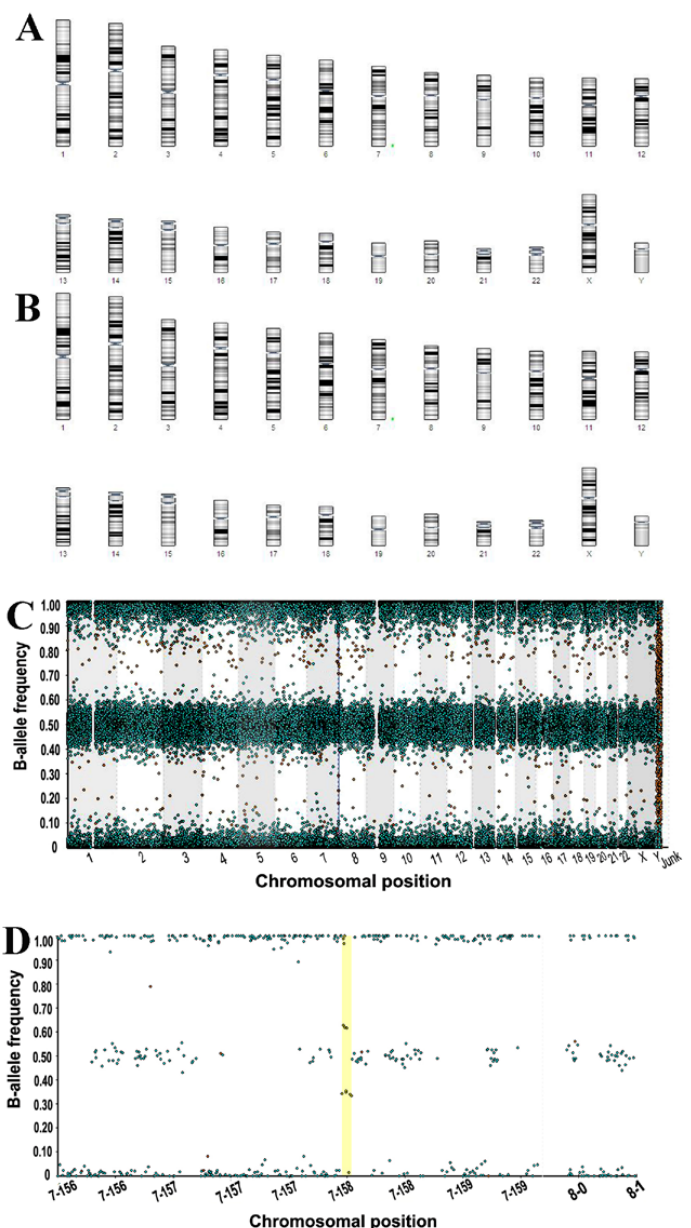
Figure 4. The results of molecular karyotyping of eMSC. ( A ) Karyotype of SHS-SP; ( B ) Karyotype of control cells; ( A , B ) scheme of genome profile with microduplication on chromosome 7; ( C ) entire genome profile with chromosome 7 microduplication; ( D ) chromosome 7 with microduplication; X on ( C ) length of all genome; X on ( D ) length of chromosome 7; Y on ( C , D ) B-allele frequency (BAF). BAF values range from 0 to 1: areas of homozygosity have BAF of 0 or 1; normal diploid regions have BAF of 0, 0.5, or 1; areas of allelic imbalance show intermediate values.